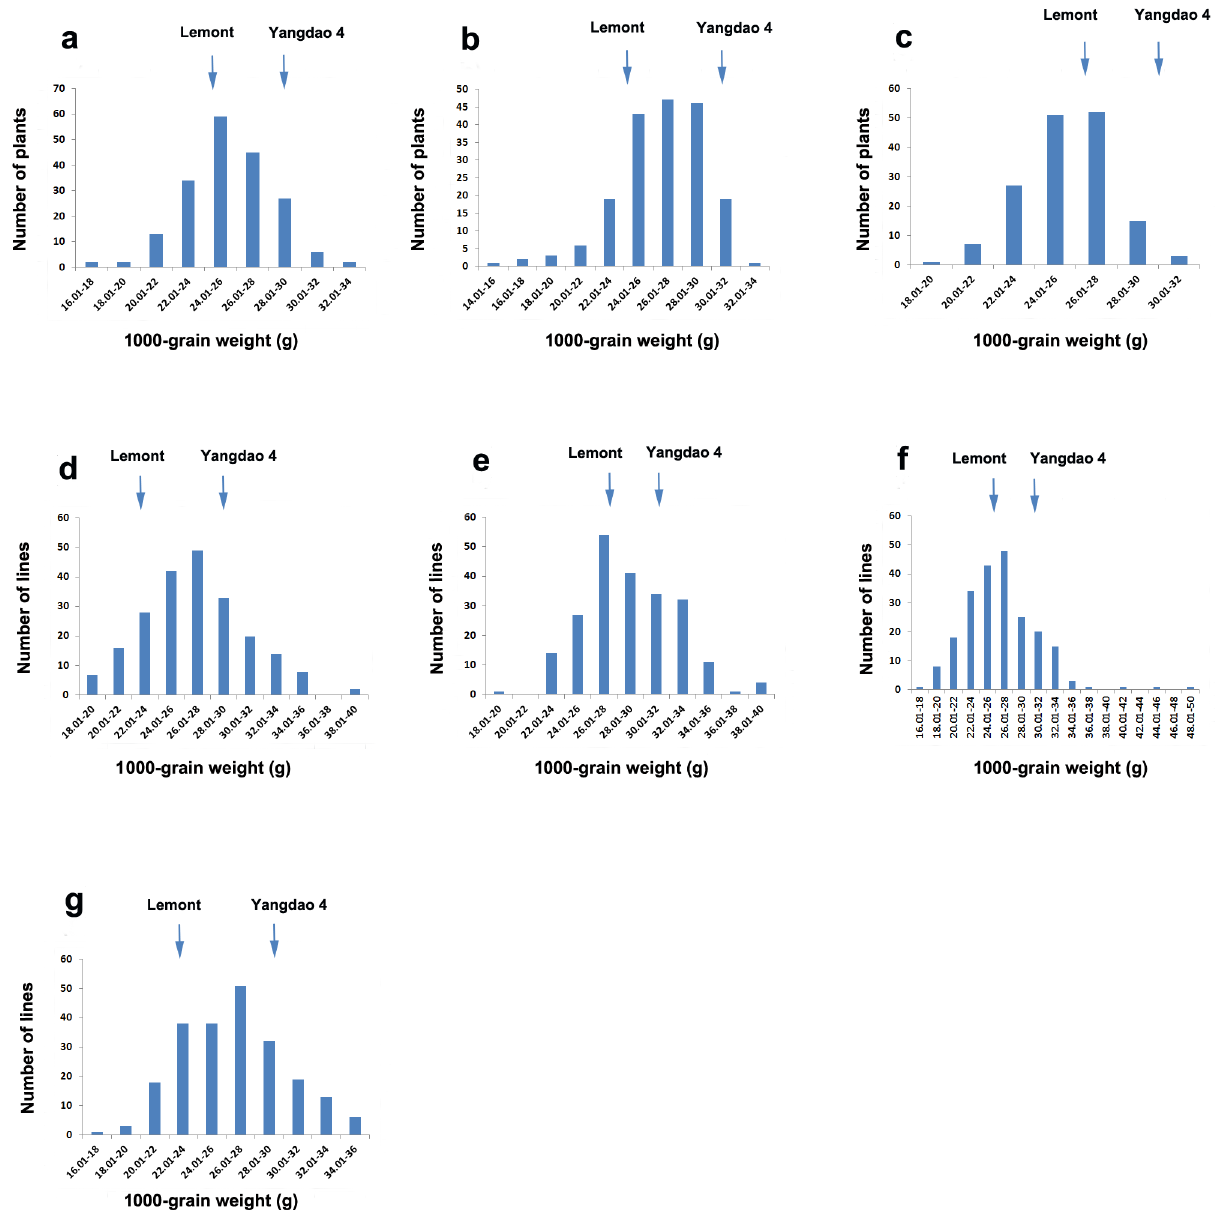
Fig 1. Frequency distribution of grain weight in the seven mapping populations derived from ‘Lemont’ × ‘Yangdao 4’ and grown under seven environments. ( a ) F 2 populationgrown in 2011in Hangzhou,( b ) F 2 population grown in 2012 in Hangzhou,( c ) F 3 population grown in 2012in Hainan, ( d ) F 7 recombinant inbredline (RIL) populationgrown in 2014 in Hangzhou,( e ) F 8 RIL populationgrown in 2014 in Hainan,( f ) F 9 RIL populationgrown in 2015 in Hangzhou, and ( g ) F 10 RIL population grown in 2015 in